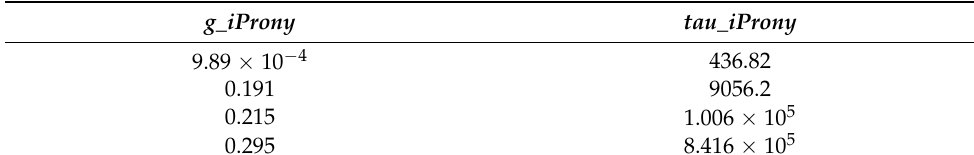
Figure 12. Fitting results for the master curve at 30 °C.